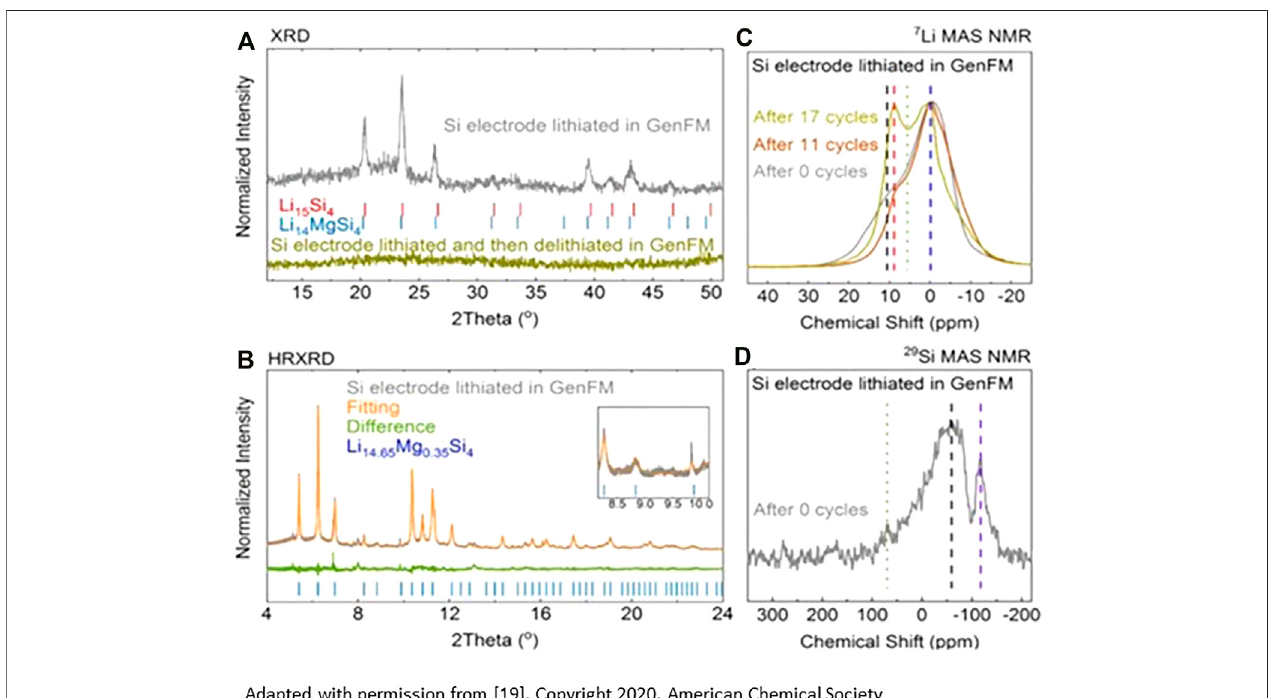
FIGURE 2 | (A) Rietveld analysis from XRD data of the phases formed, (B) high resolution XRD of the cycled materials with stoichiometric re fi nement; (C) 7Li NMR study on cycled materials showing the growth of a second phase (Li-Mg-Si) on cycling; (D) 29 Si MAS NNMR study highlighting formation of a second reduced silicon phase. Both spectra are consistent with gradual formation of a ternary Li-Mg-Si phase(s) on cycling in the Mg-containing electrolyte. [from reference